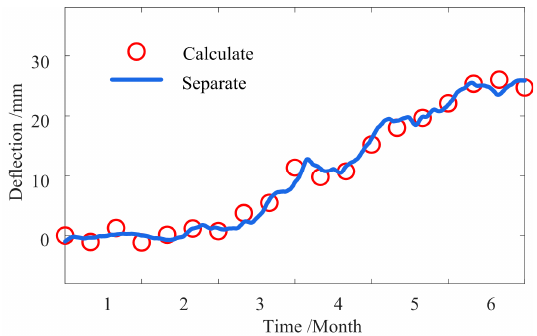
Figure 18. Comparison between the calculation results of the FEM and the separated deflection.